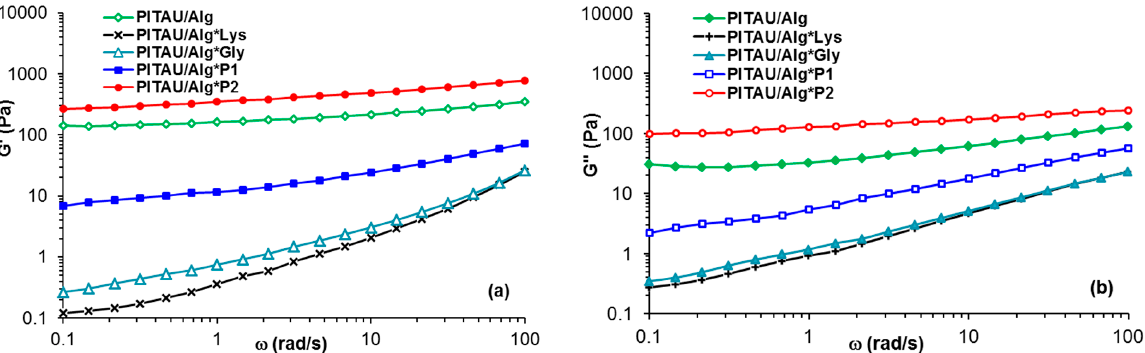
Figure 4. The elastic ( a ) and viscous ( b ) moduli as a function of the oscillation frequency for the investigated samples ( γ = 1%).